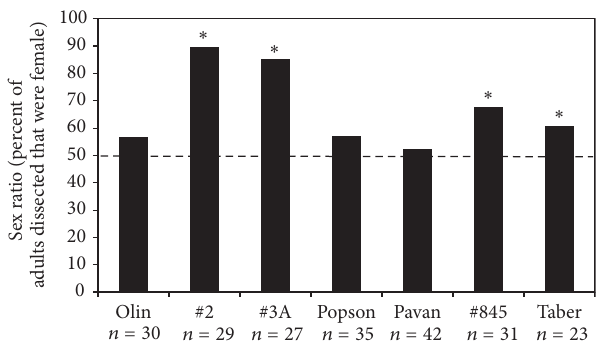
(cid:2412) (cid:30) (cid:20)(cid:17) (cid:2412) (cid:30) (cid:19)(cid:26) (cid:2412) (cid:30) (cid:19)(cid:24) (cid:2412) (cid:30) (cid:20)(cid:22) (cid:2412) (cid:30) (cid:21)(cid:19) (cid:2412) (cid:30) (cid:20)(cid:18) (cid:2412) (cid:30) (cid:19)(cid:20) F 3: Sex ratios of longnose dace ( Rhinichthys cataractae ) collected from the Oldman River during August and September, 2009. Asterisks indicate that the sex ratio at the site is signi�cantly different from 50:50 (dashed line for reference) at as determined by chi-square 𝑃𝑃 𝑃 0𝑃0𝑃